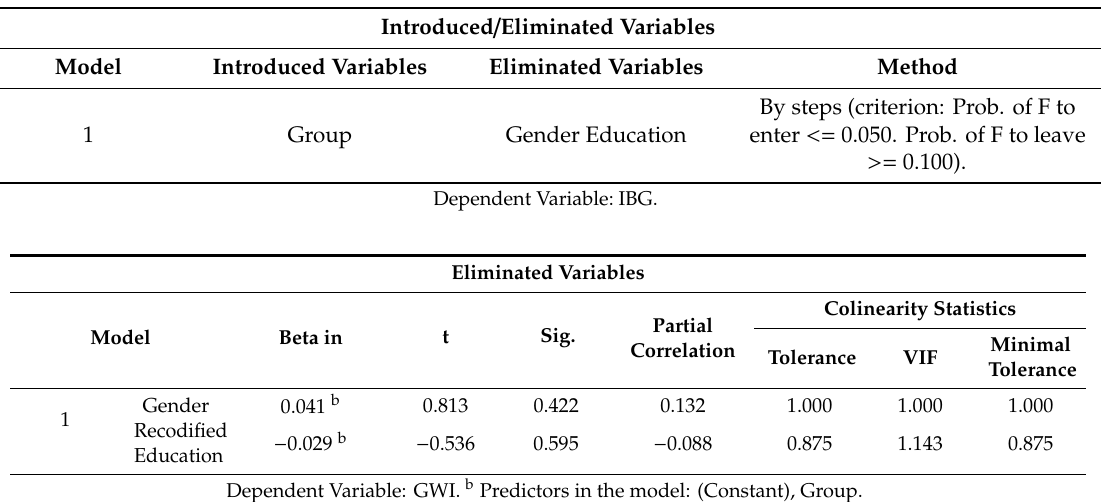
Table 20. Regression